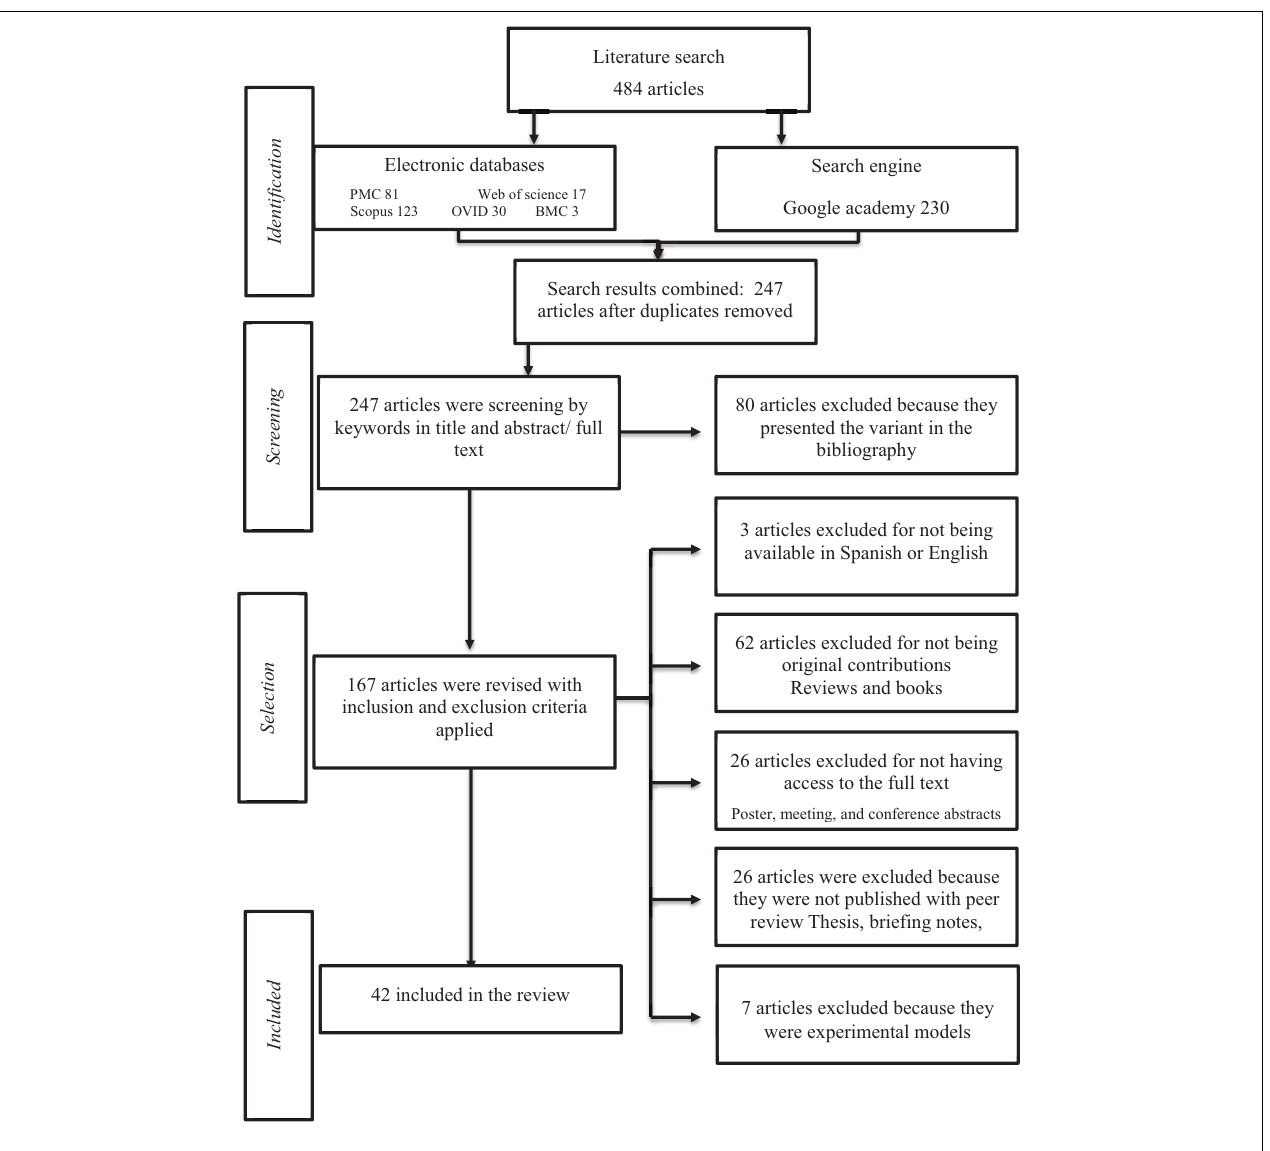
FIGURE 1 | Screening